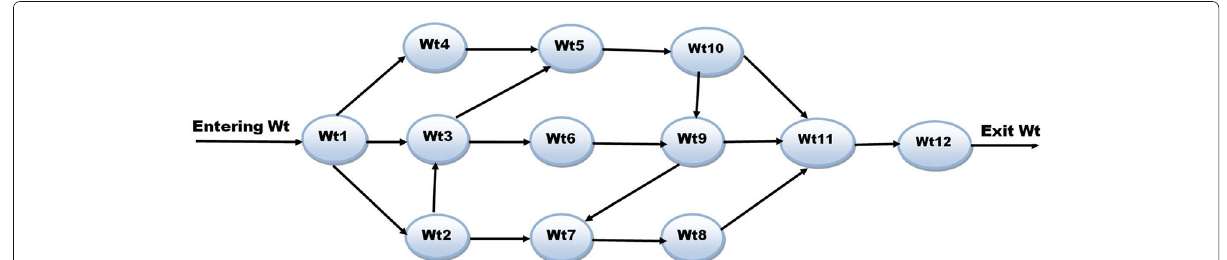
Fig. 1 Sample workflow dag with entering and exit workflow tasks